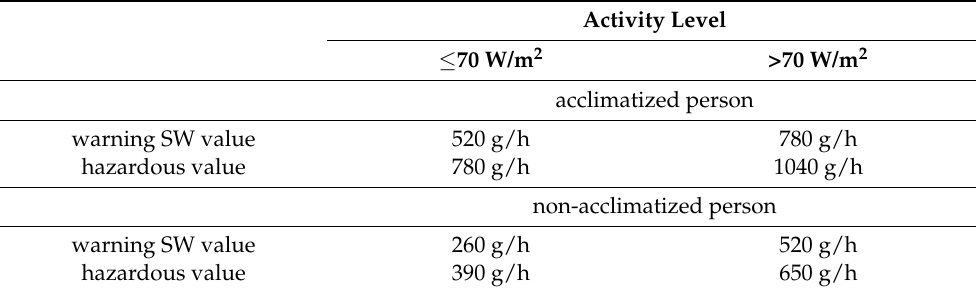
Table 3. Water loss index (SW) threshold values regarding heat thermal stress (ISO standard